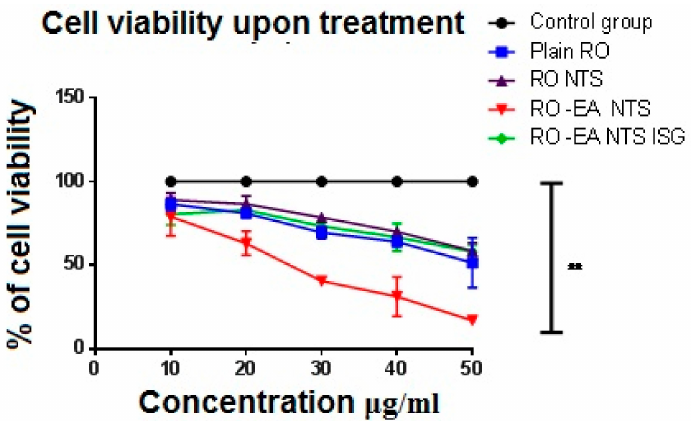
Figure 9. E ff ect of plain RO, RO-NTS, RO-EA-NTS, and RO-EA-NTS loaded in situ gel, and 5 Fluoro-Uracil (control) on the viability of the HSC-3 cell line. The values represent the mean ± SD of three independent experiments ( n = 9).